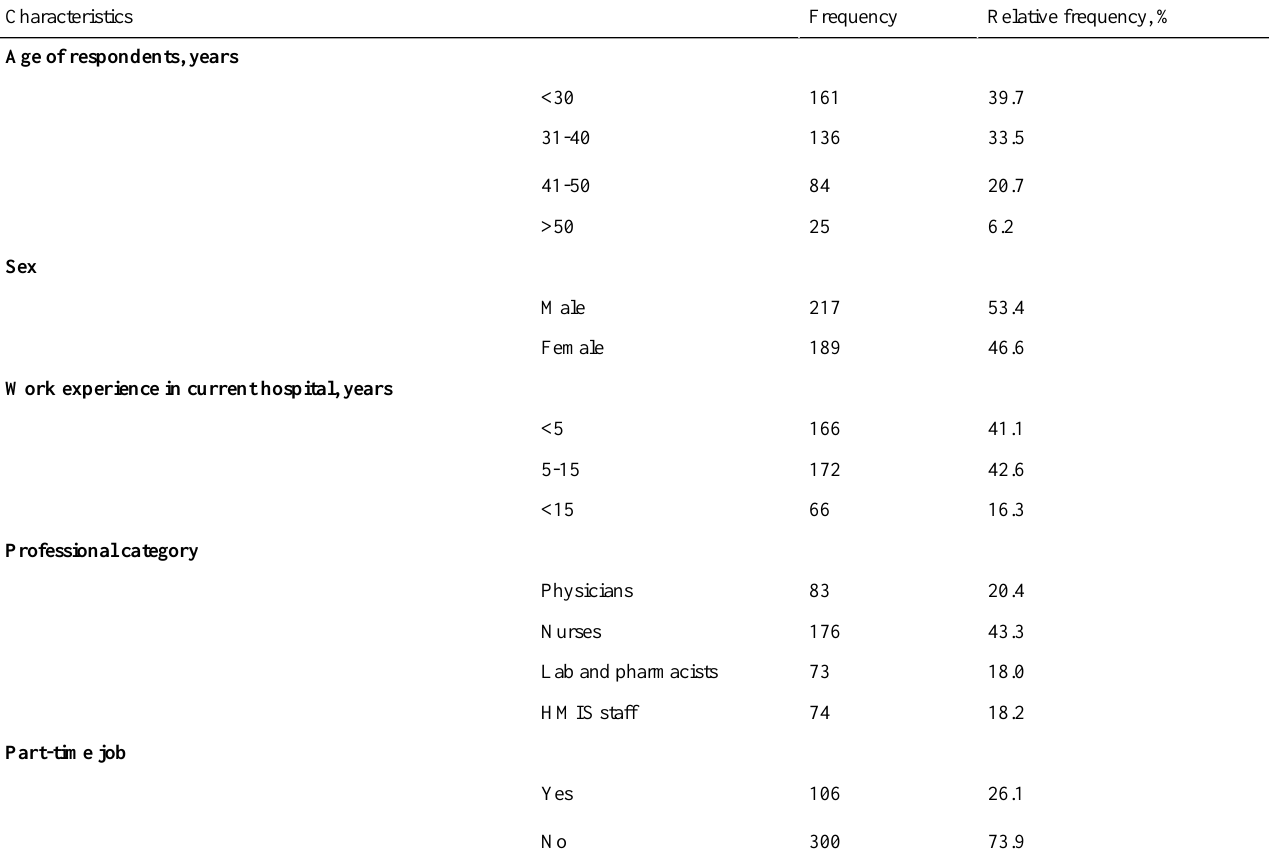
Table 1. Frequencies of the socio-demographic characteristics of the study participants (n=406).